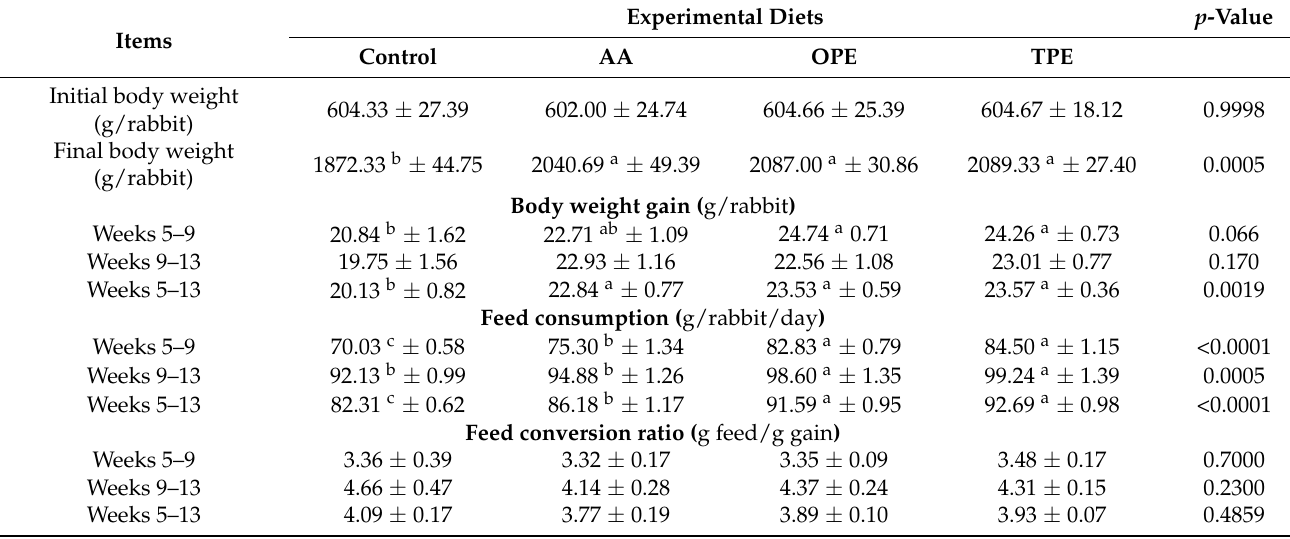
Table 3. Growth performance of growing rabbits fed diets supplemented with AA, OPE and TPE during different ages.